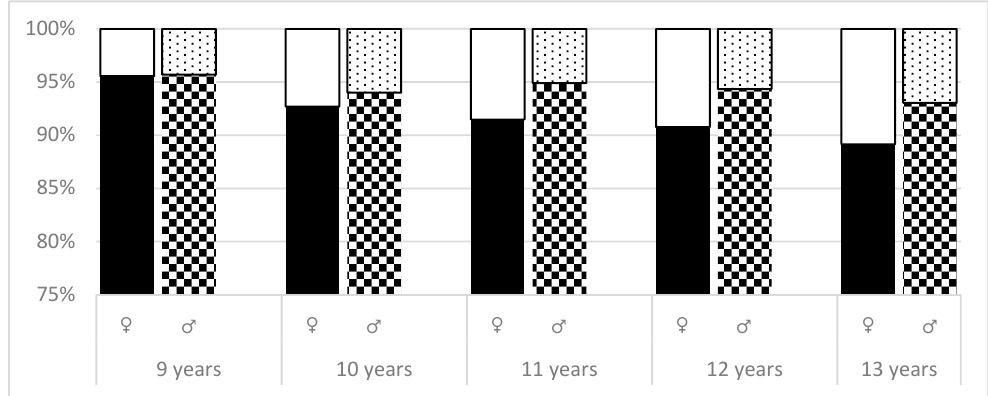
Figure 3. ATR absolute values—comparison of differences between age and sex (level 3).